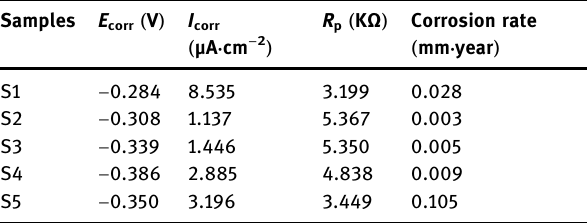
Table 3: Corrosion parameters of the samples evaluated